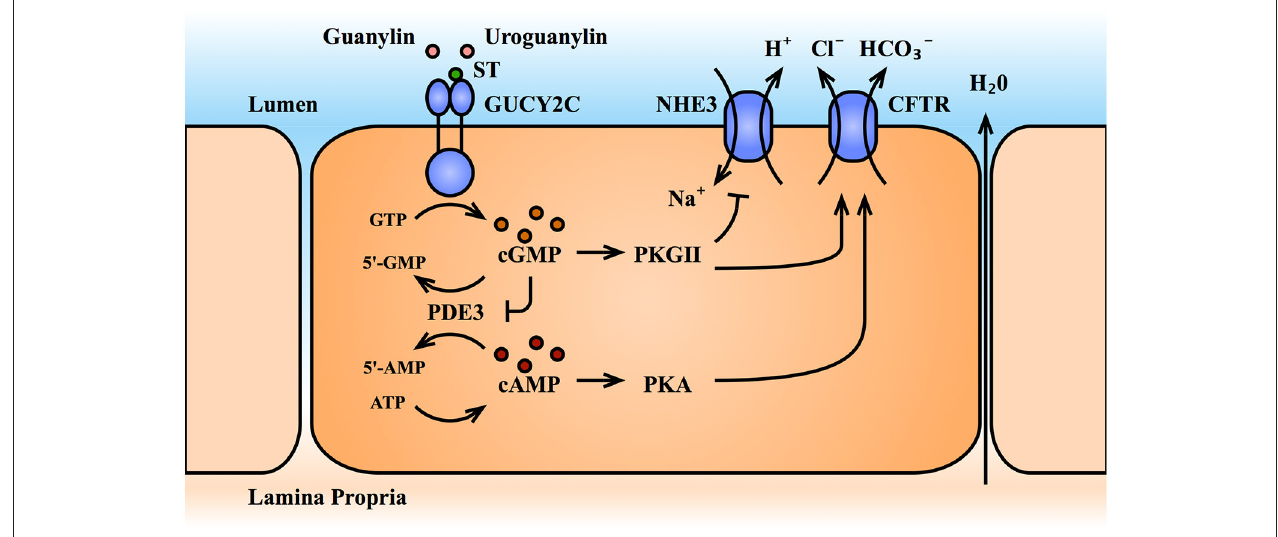
FIGURE 2 | The GUCY2C-cGMP signaling axis and intestinal fluid secretion. Activation of the receptor GUCY2C by its ligands increases intracellular cGMP levels. The cGMP effector, PKGII, inhibits sodium ion absorption by the NHE3 transporter, and promotes anion secretion by the CFTR transporter, producing an electrolyte and fluid gradient into the gut lumen. Through inhibition of the dual-specificity phosphodiesterases, PDE3, cGMP accumulation also cross-activates cAMP/PKA signaling, which further potentiates CFTR. ATP, adenosine triphosphate; cAMP, cyclic adenosine monophosphate; CFTR, cystic fibrosis transmembrane conductance regulator; cGMP, cyclic guanosine monophosphate; GTP, guanosine triphosphate; GUCY2C, guanylate cyclase C; NHE3, Na + /H + exchanger III; PDE3, phosphodiesterases III; PKA, protein kinase A; PKGII, protein kinase G II; ST, bacterial heat-stable enterotoxin; 5 ′ -AMP, 5 ′ -adenosine monophosphate; 5 ′ -GMP, 5 ′ -guanosine